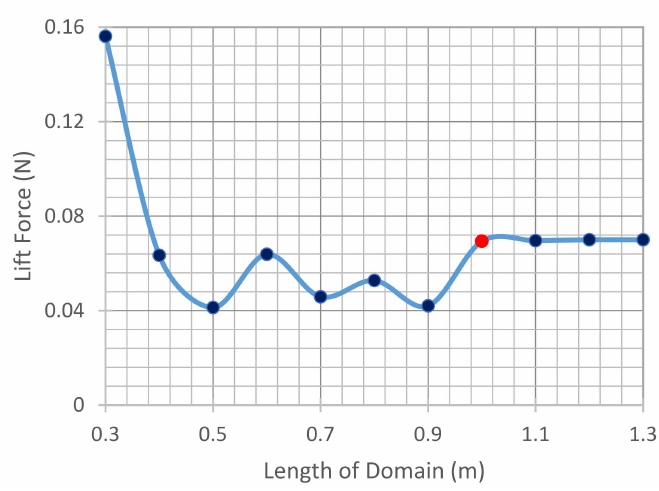
Figure 18. Domain Length Convergence Plot.